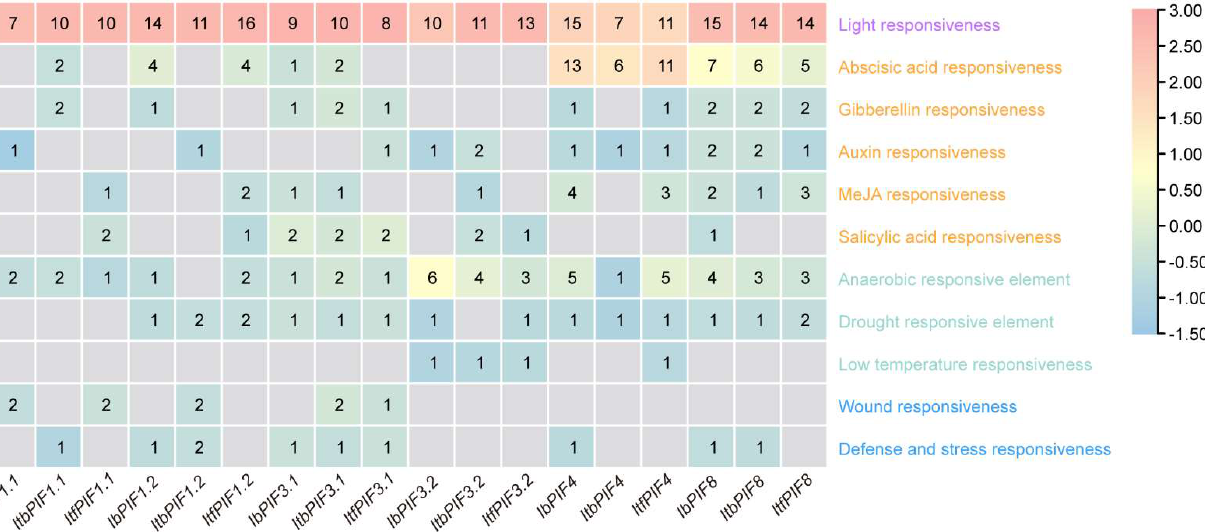
triloba , and I. trifida . The yellow boxes, green boxes, and grey lines represent the UTR, exons, and introns, respectively.